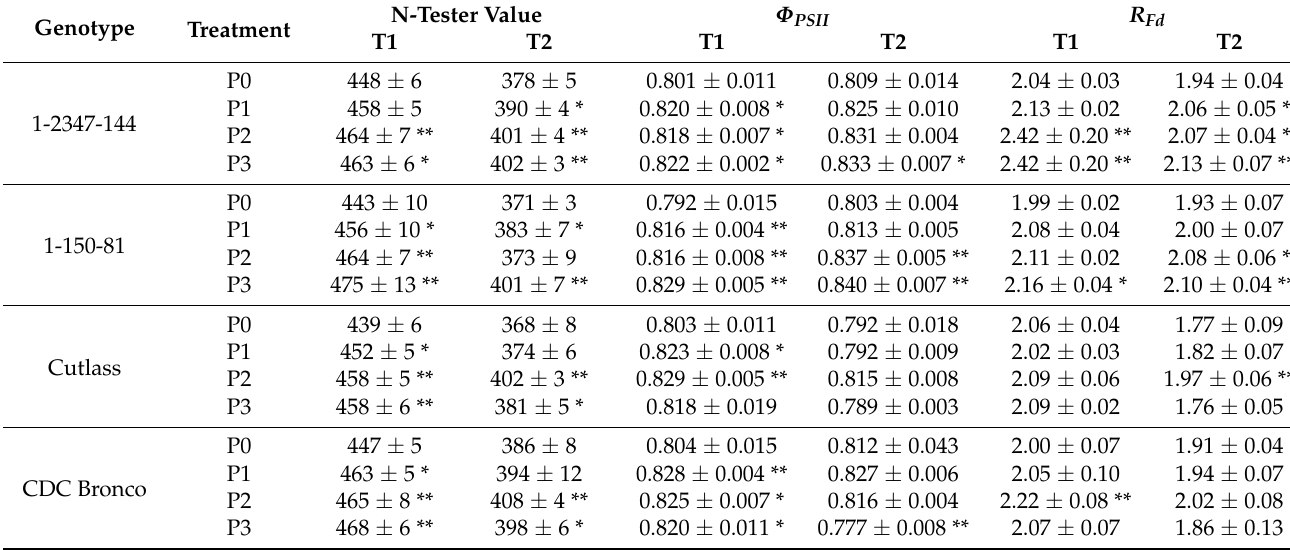
Table 1. The effect of the foliar phosphorus application on chlorophyll contents (N-tester value) and chlorophyll fluorescence parameters ( Φ PSII and R Fd